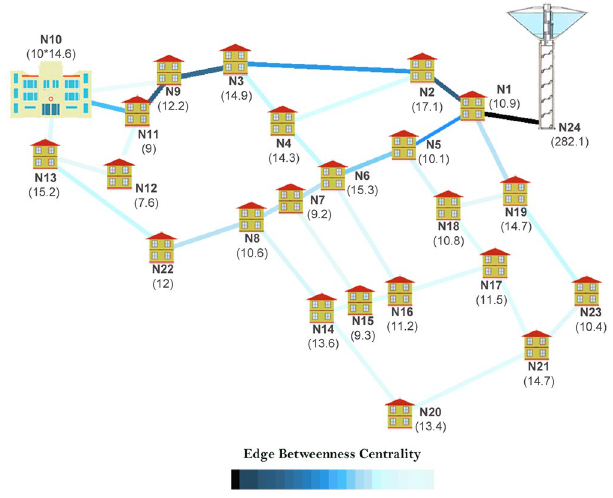
Figure 9. Intrinsic relevance-embedding edge betweenness when a hospital is present in the vertex 10. Its intrinsic relevance is ten times its demand. The proposed edge betweenness again identifies pipe 34 as the most important, but the main path in the network changes in favor of those connecting the source node and the